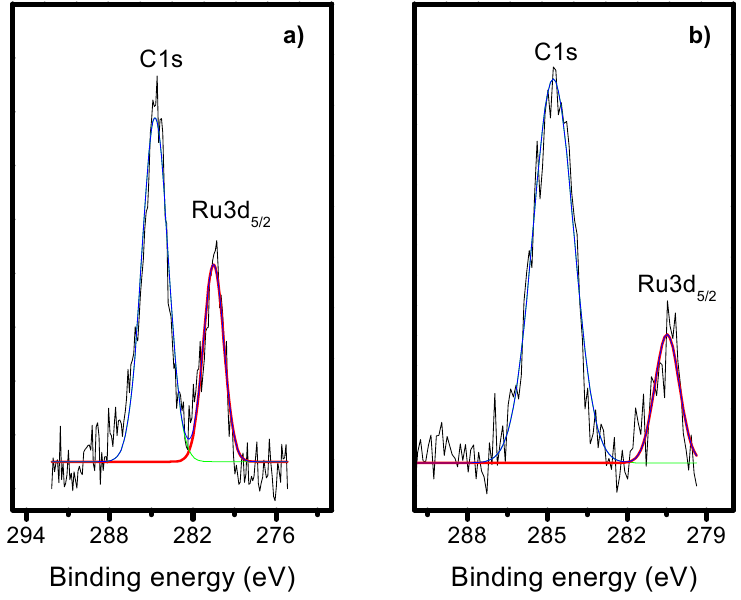
Figure 3. General X-ray photoelectron spectroscopy (XPS) scan of ( a ) MBR1 and ( b ) MBR2 support catalysts.